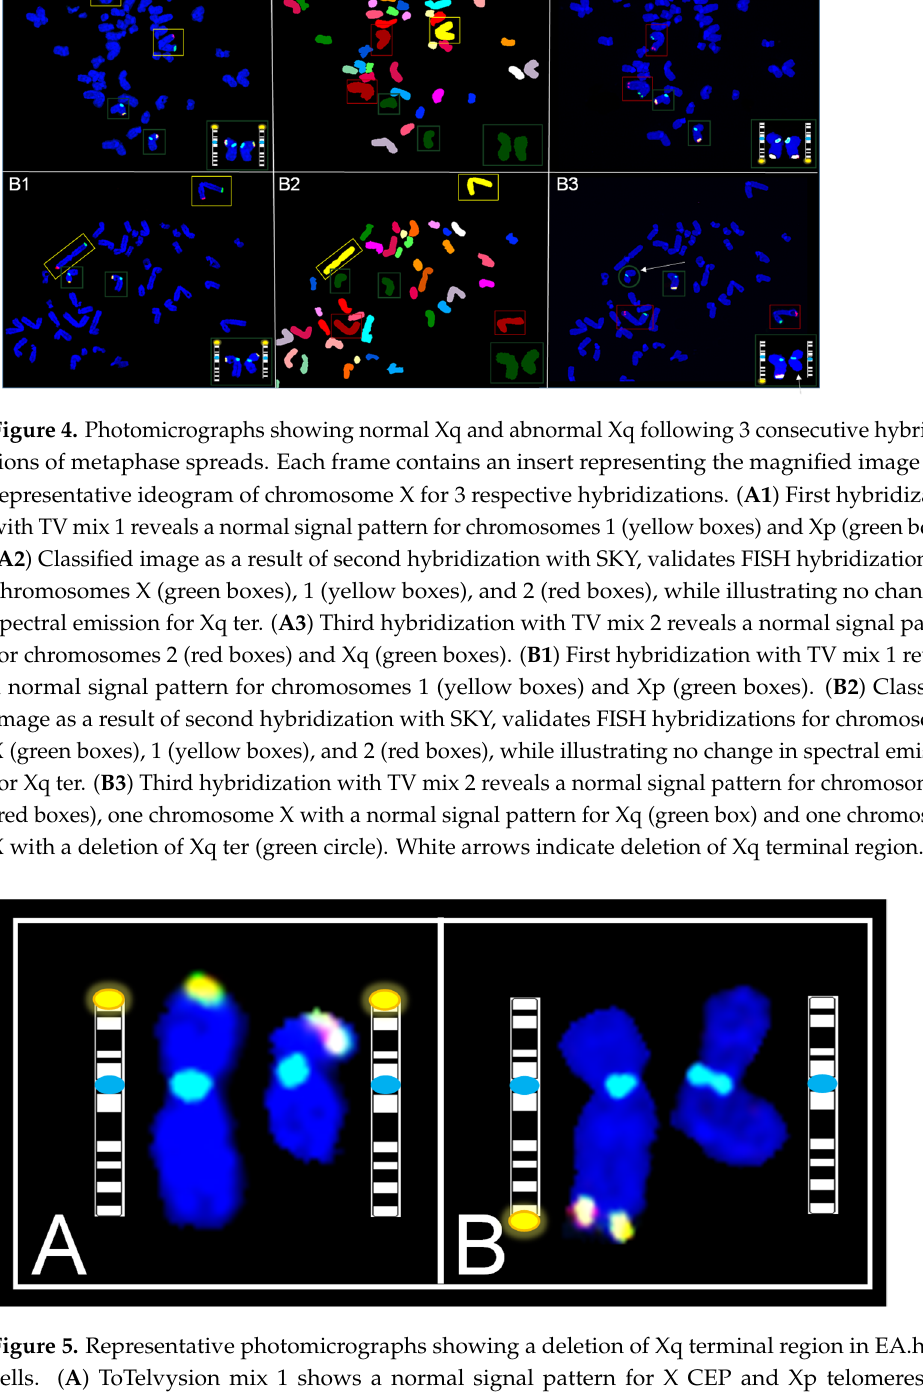
Figure 5. Representative photomicrographs showing a deletion of Xq terminal region in EA.hy926 cells. ( A ) ToTelvysion mix 1 shows a normal signal pattern for X CEP and Xp telomeres and ( B ) ToTelVysion mix 2 reveals a normal signal pattern for X CEP in both chromosomes and a deletion of one homologue of chromosome Xq telomere. Idiograms of chromosome X showing Xp ( A ) and Xq ( B ) terminal regions (highlighted).